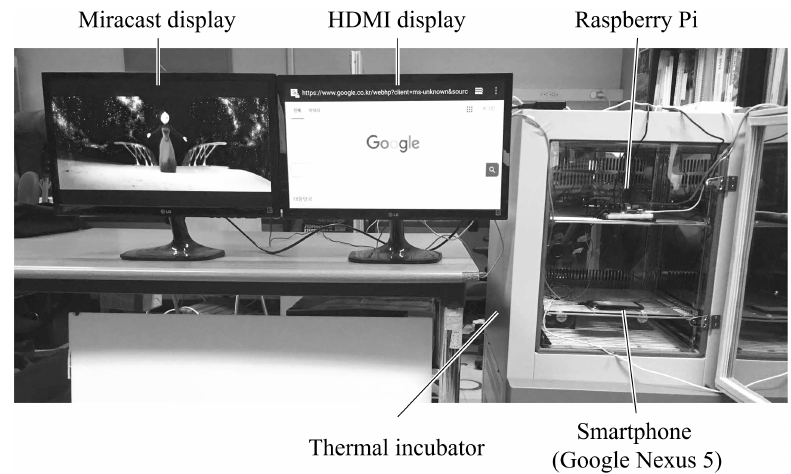
Figure 17. Experimental